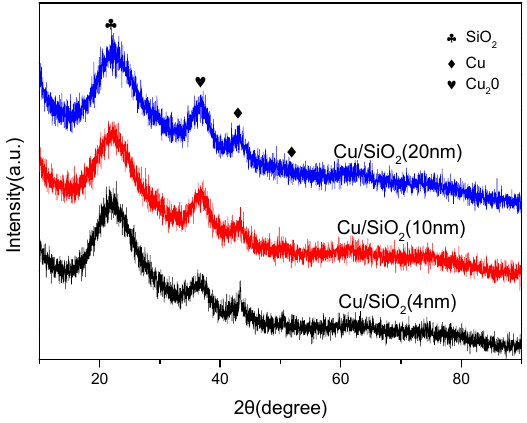
Figure 3. The x-ray diffraction (XRD) patterns of the reduced catalysts.